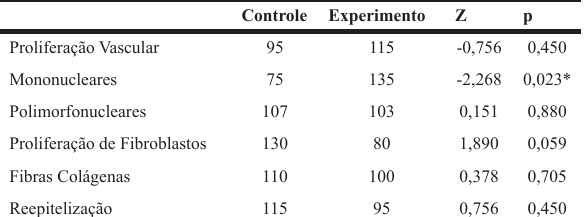
FIGURA 9 - Fotomicrografia do grupo experimento do 7º dia. Nota: Figura mostra a ausência de epitélio (A), presença de vasos com neoformação (B) e de polimorfonucleares (C) (H-E com aumento de 10x